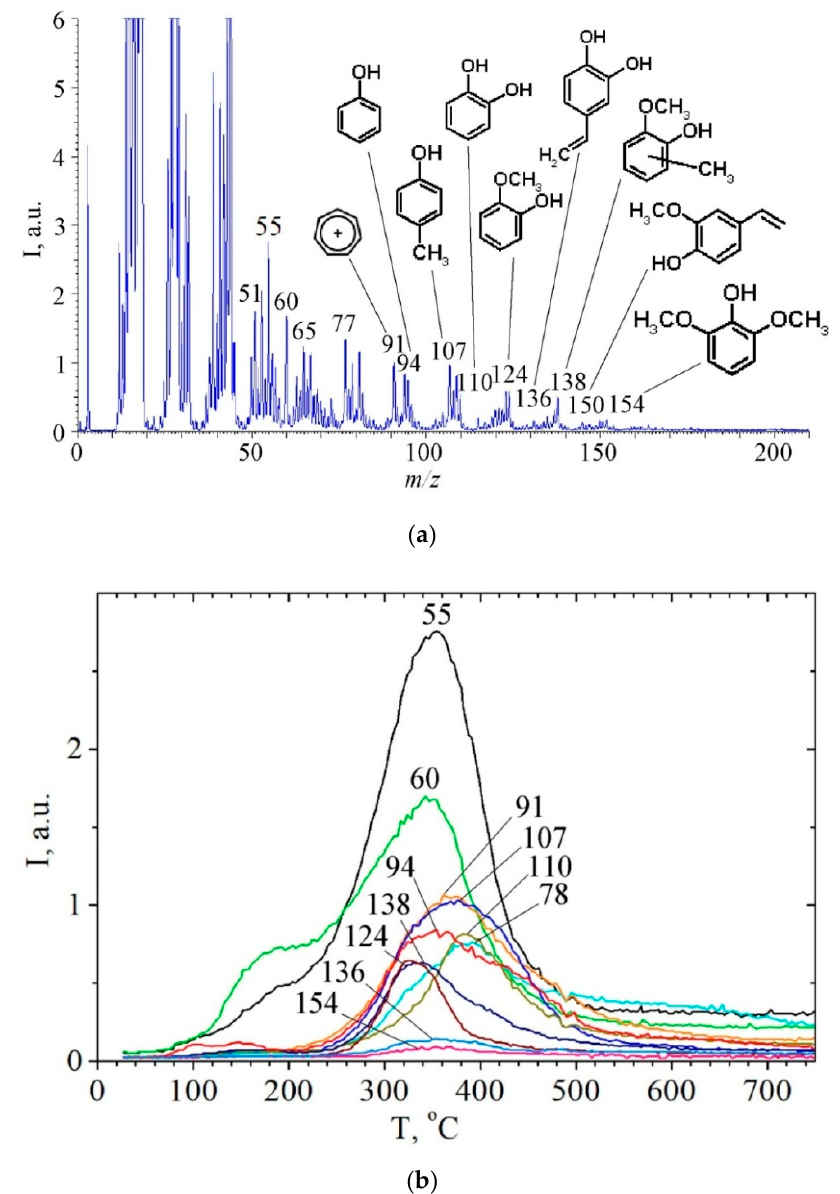
Figure 3. Mass spectra of pyrolysis products of rice husk hydrolytic lignin at 354 °C obtained after electron impact ionization ( a ), and TPD-curves of the ions with m/z 154, 138, 136, 124, 110, 107, 94, 91, 78, 60, 55 under pyrolysis of rice husk hydrolytic lignin ( b ).